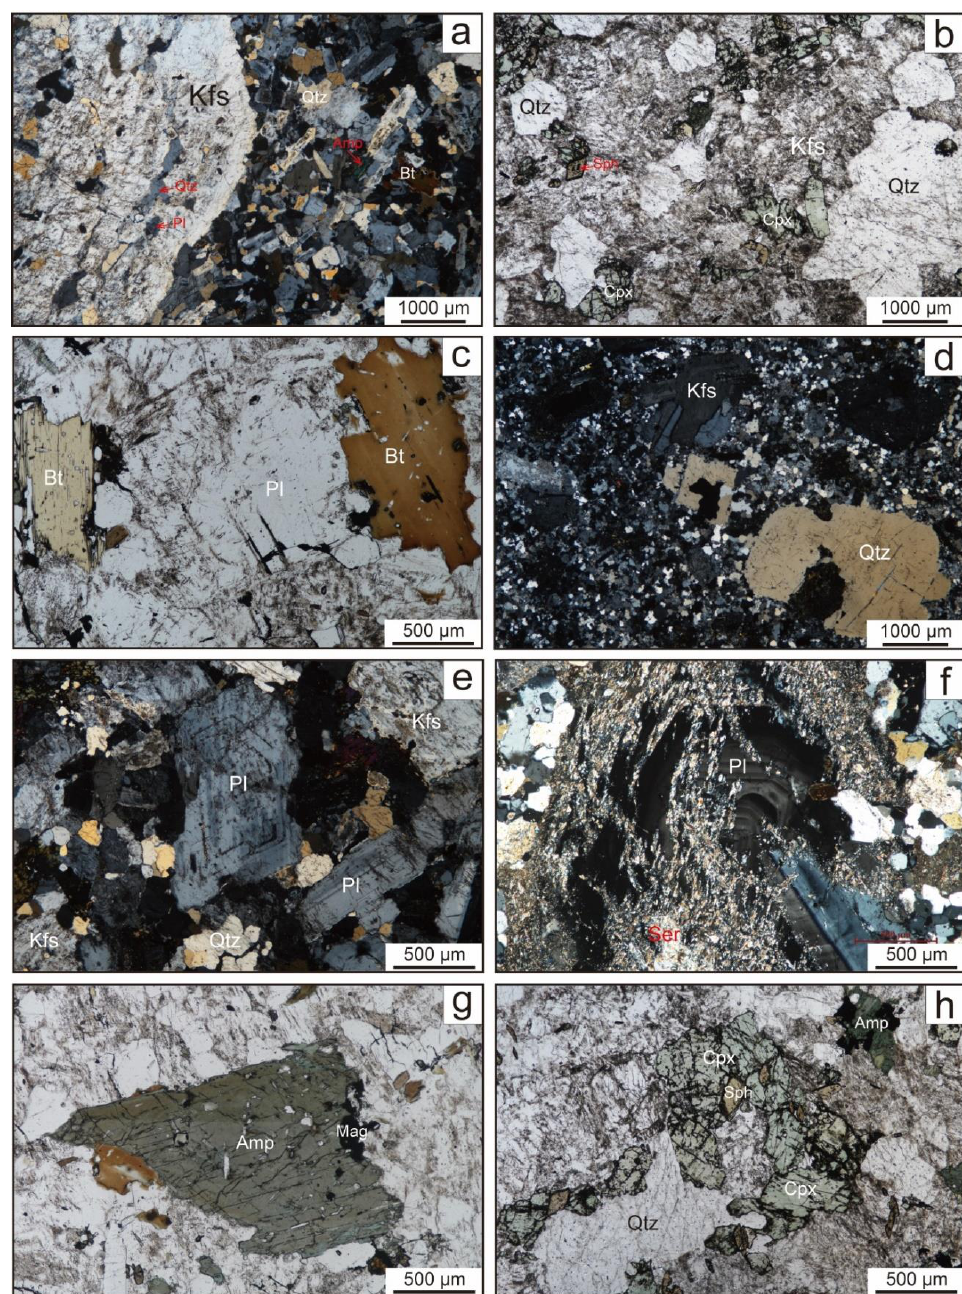
Figure 4. Micrographs of the granite porphyry samples in this study showing typical structures and mineral assemblages. ( a ) Large K-feldspar phenocryst with plagioclase and quartz inclusions compared with fine-sized matrix; ( b ) Quartz and K-feldspar in phenocrysts and smaller clinopyroxene and sphene in matrix; ( c ) Plagioclase and biotite in phenocrysts; ( d ) Large quartz and K-feldspar crystals in phenocrysts and fine-sized feldspar, quartz, and minor mafic minerals in matrix; ( e ) Plagioclase crystals with polysynthetic twining and zoning texture; ( f ) Plagioclase phenocryst with oscillatory zoning were later altered into sericites; ( g ) Amphibole phenocryst coexists with magnetite; ( h ) Clinopyroxene phenocryst coexists with quartz phenocryst and encloses small sphene grains. Kfs = K-feldspar, Pl = plagioclase, Qtz = quartz, Cpx = clinopyroxene, Amp = amphibole, Bt = biotite, Sph = sphene, Mag = magnetite, Ser = sericite.